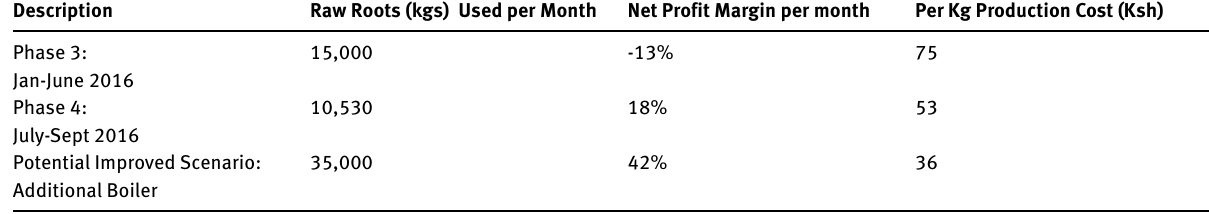
Table 2: Change in Profit Margins and Unit Costs Since January 2016 and Desired Target